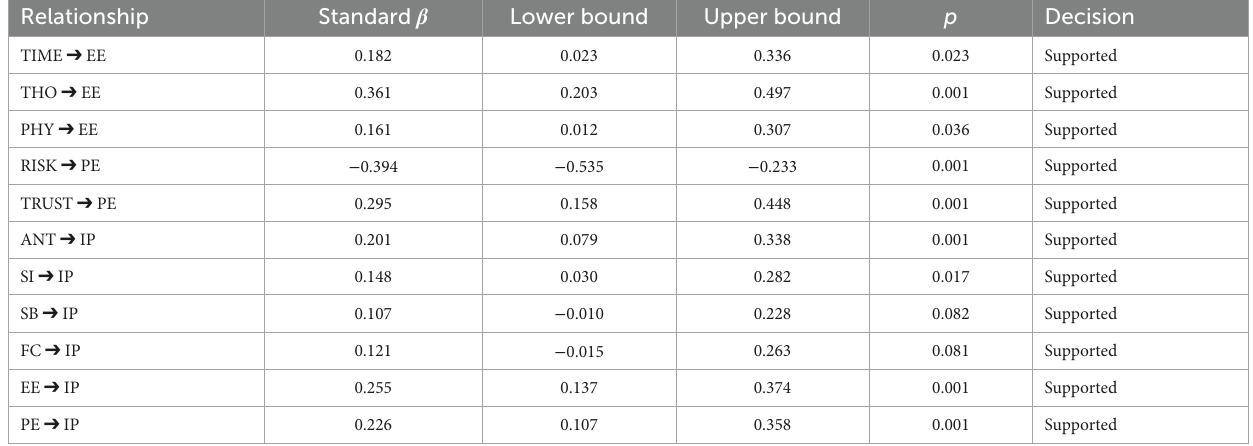
TABLE 10 The bootstrap estimation of standard path coefficients (95% bias-corrected